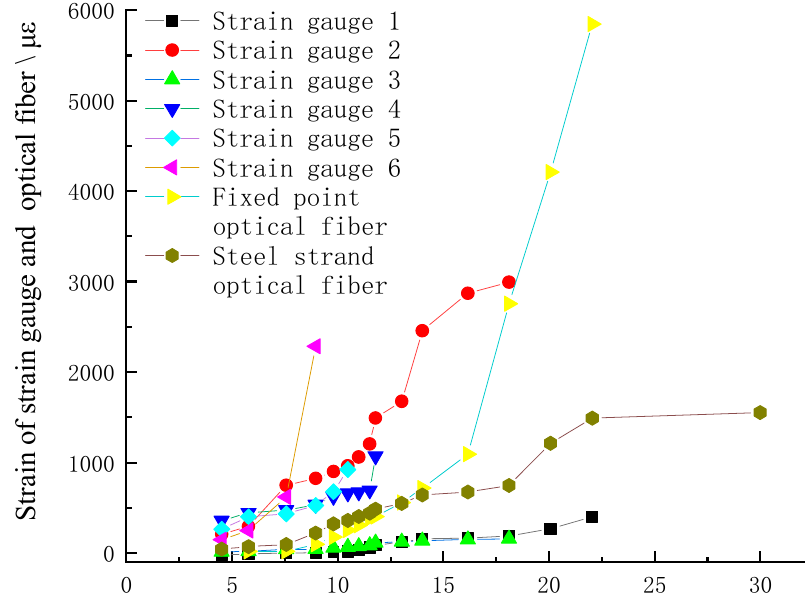
Figure 9. Strain comparison between strain gauge and fiber.